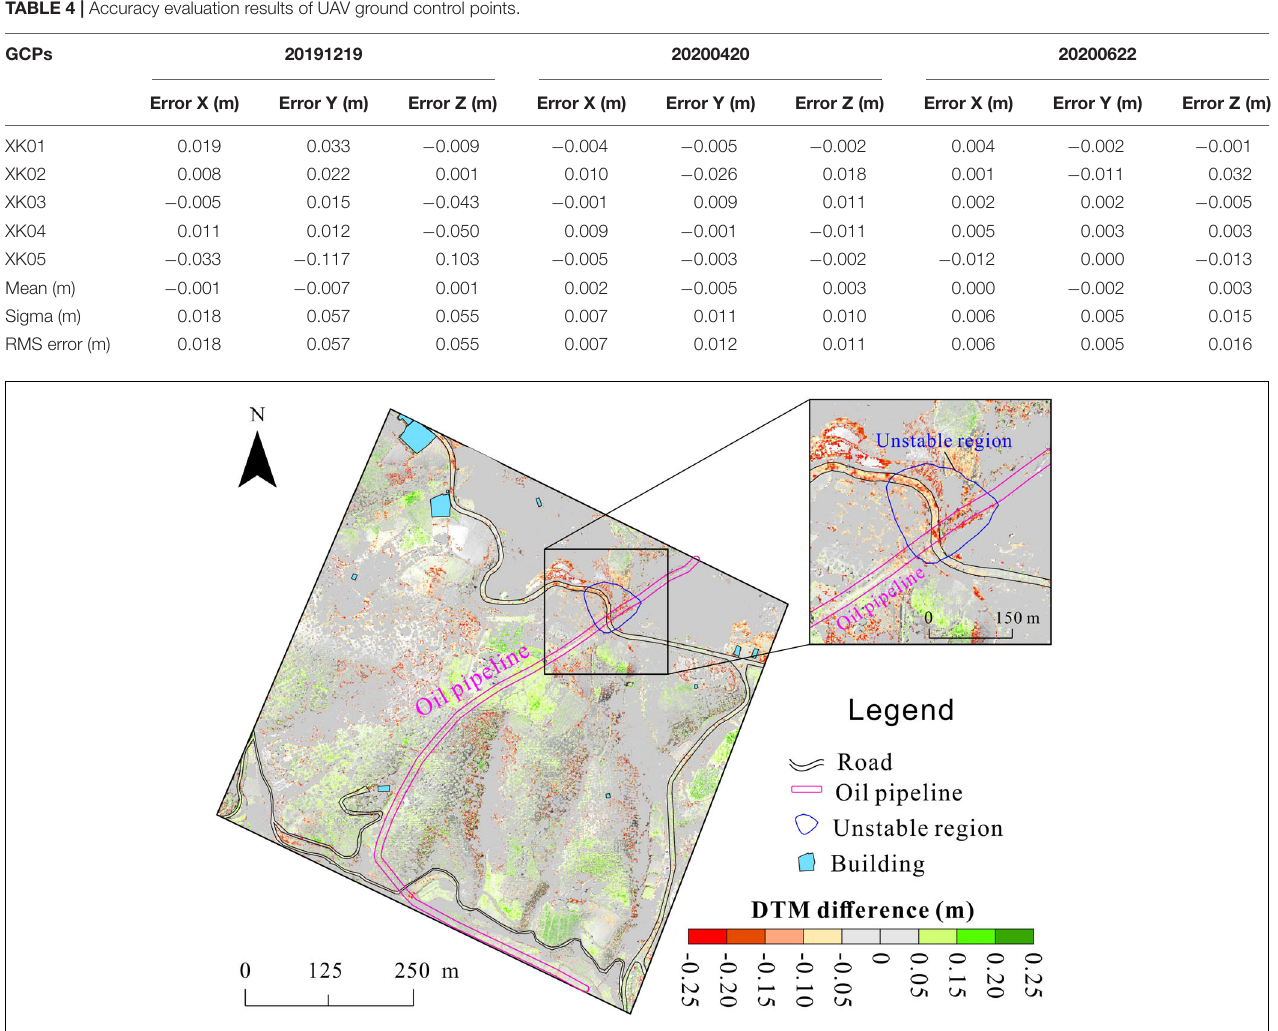
FIGURE 10 | The results of DTMs of difference (DoDs) from December 2019 to June 2020.